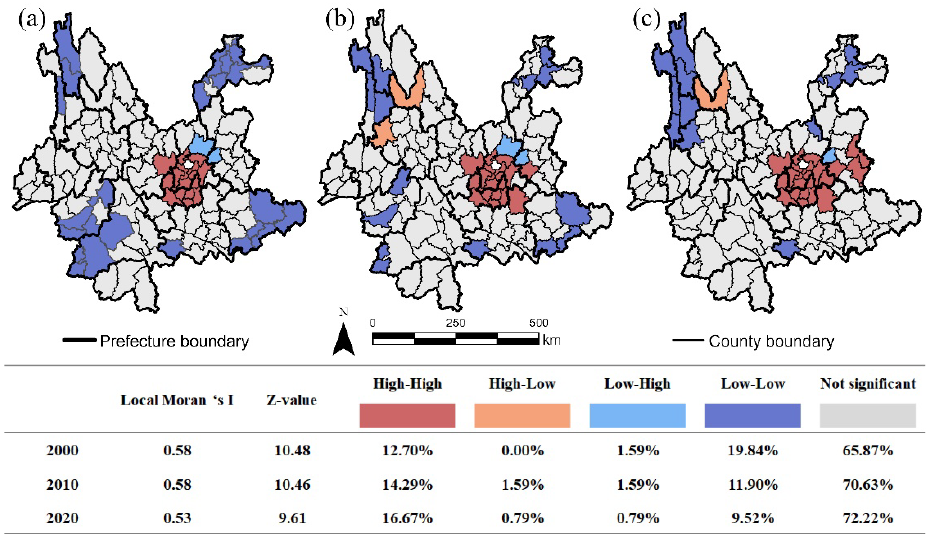
Figure 4. Results of spatial correlation of rural income in: ( a ) 2000, ( b ) 2010 and ( c ) 2020.